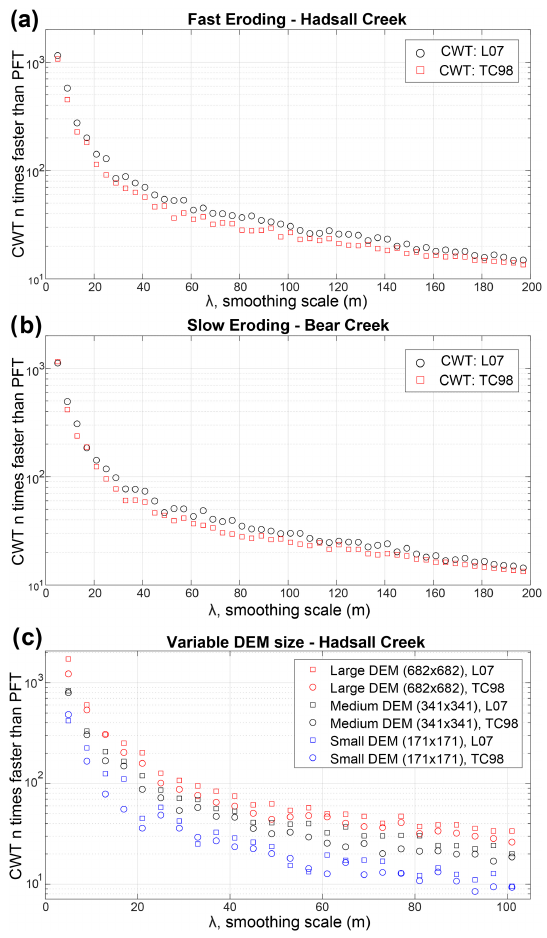
Figure 4. Speed of the CWT compared to the PFT for differ- ent smoothing scales, λ . (a, b) Relative speed of the CWT to the PFT for small portions (513 × 513 single precision grid, cell size of 0.9144m) of the Hadsall and Bear Creek catchments, quantified as the ratio of CWT / PFT processing time. Thus, for each smooth- ing scale, each point can be interpreted as the CWT being n times faster than the PFT. At small λ , the CWT is > 1000 times faster than the PFT. The CWT remains > 100 times faster than the PFT until λ ≈ 30m, a scale that is usually larger than most smoothing scales utilized in C HT calculation. (c) Relative speed of the CWT to PFT for DEMs of various size in Hadsall Creek for λ = 5–101m. Largest DEM is 682 × 682 pixels. The medium-sized DEM is the upper-left quadrant of the large DEM (341 × 341 pixels), and the small DEM is upper-left quadrant of medium DEM (171 × 171 pixels). Note that the CWT increases in relative speed as DEM size increases. L07: Lashermes et al. (2007); TC98: Torrence and Compo